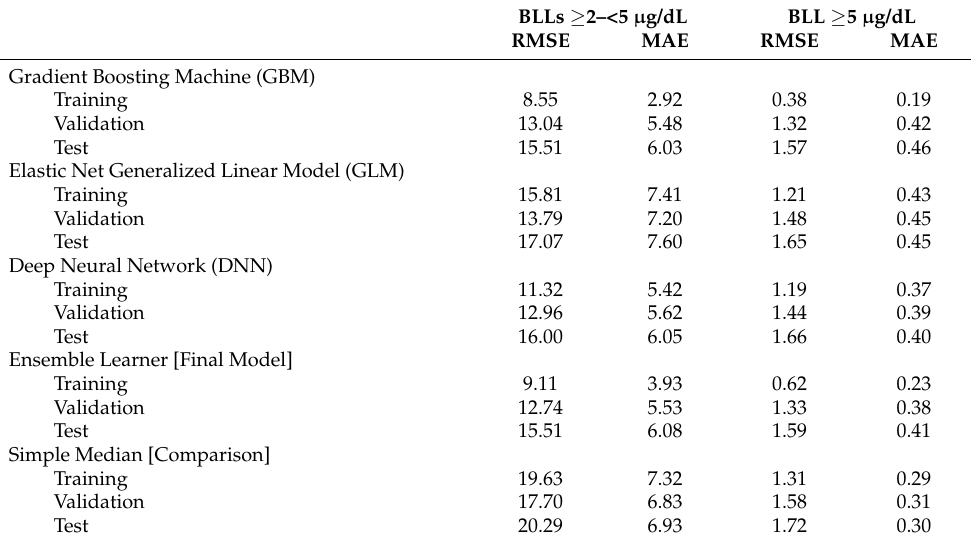
Table 3. Model performance when predicting the number of BLLs ≥ 2–<5 µ g/dL and ≥ 5 µ g/dL across base models for training, validation, and test data.